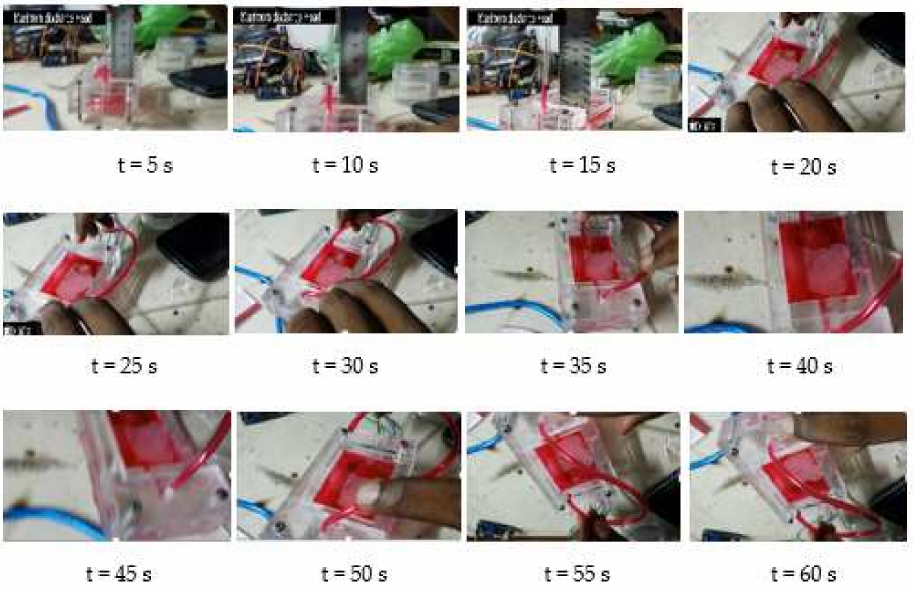
Figure 11. Flow rate of the fabricated pump through one minute.